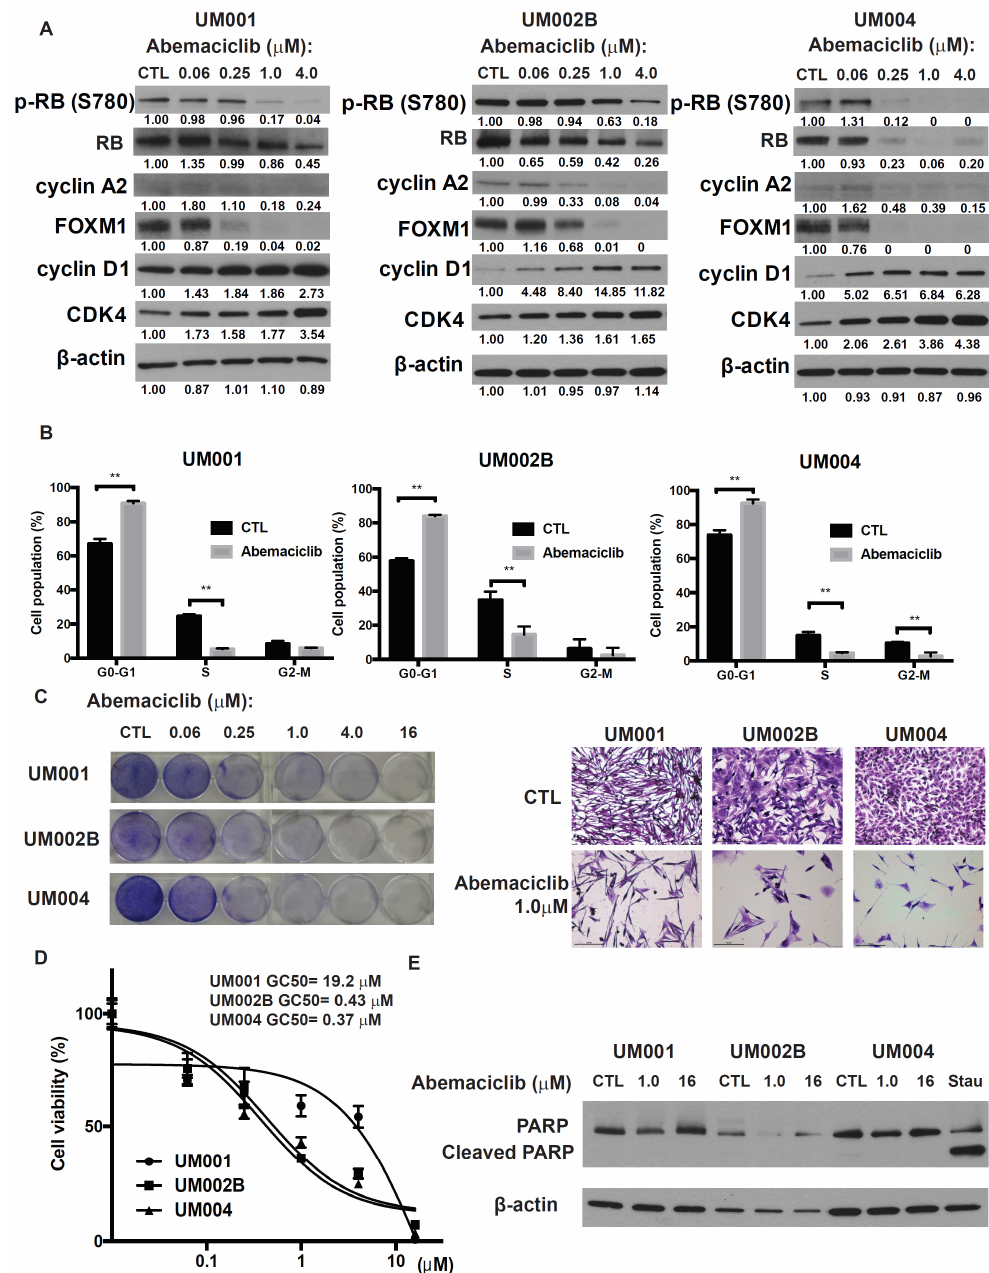
Figure 1. Abemaciclib induces G1 arrest and decreases cell growth in metastatic uveal melanoma cells. ( A ) UM001, UM002B, and UM004 cells were treated with DMSO or different concentrations of abemaciclib as indicated for 48 h. Cell lysates were probed with phospho-retinoblastoma (RB), total RB, cyclin A2, FOXM1, cyclin D1, CDK4, and β -actin antibodies. ( B ) Cells were treated with DMSO or 1 µ M abemaciclib for 24 h. Cells were then fixed, permeabilized, and subjected to PI staining. Cell-cycle analysis was performed with FlowJo software. ** p < 0.01, based on the two sample t -test with unequal variance. ( C ) UM001, UM002B, and UM004 cells were treated with DMSO or different concentrations of abemaciclib as indicated. After seven days, cells were subjected to crystal violet staining. Representative microscopic images of the cells at × 200 magnification are shown. Scale bar, 100 µ m. ( D ) UM001, UM002B, and UM004 cells were seeded in 96-well plates overnight and then treated with increasing doses of abemaciclib for 96 h. Cell viability was analyzed by the MTS assay. GI 50 values were calculated using Graph pad Prism. ( E ) UM001, UM002B, and UM004 cells were treated with DMSO or different concentrations of abemaciclib as indicated for 48 h. Cell lysates were probed with PARP and β -actin antibodies. Stau, UM004 cells were treated with 0.5 µ M of staurosporine for 3 h as a positive